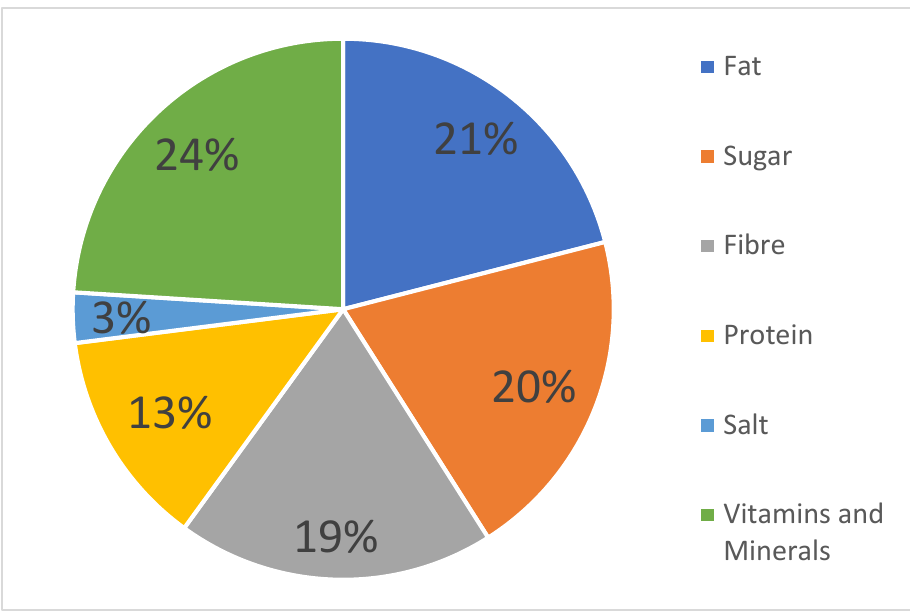
Figure 1. Proportion of nutrients referred to in nutrition claims.